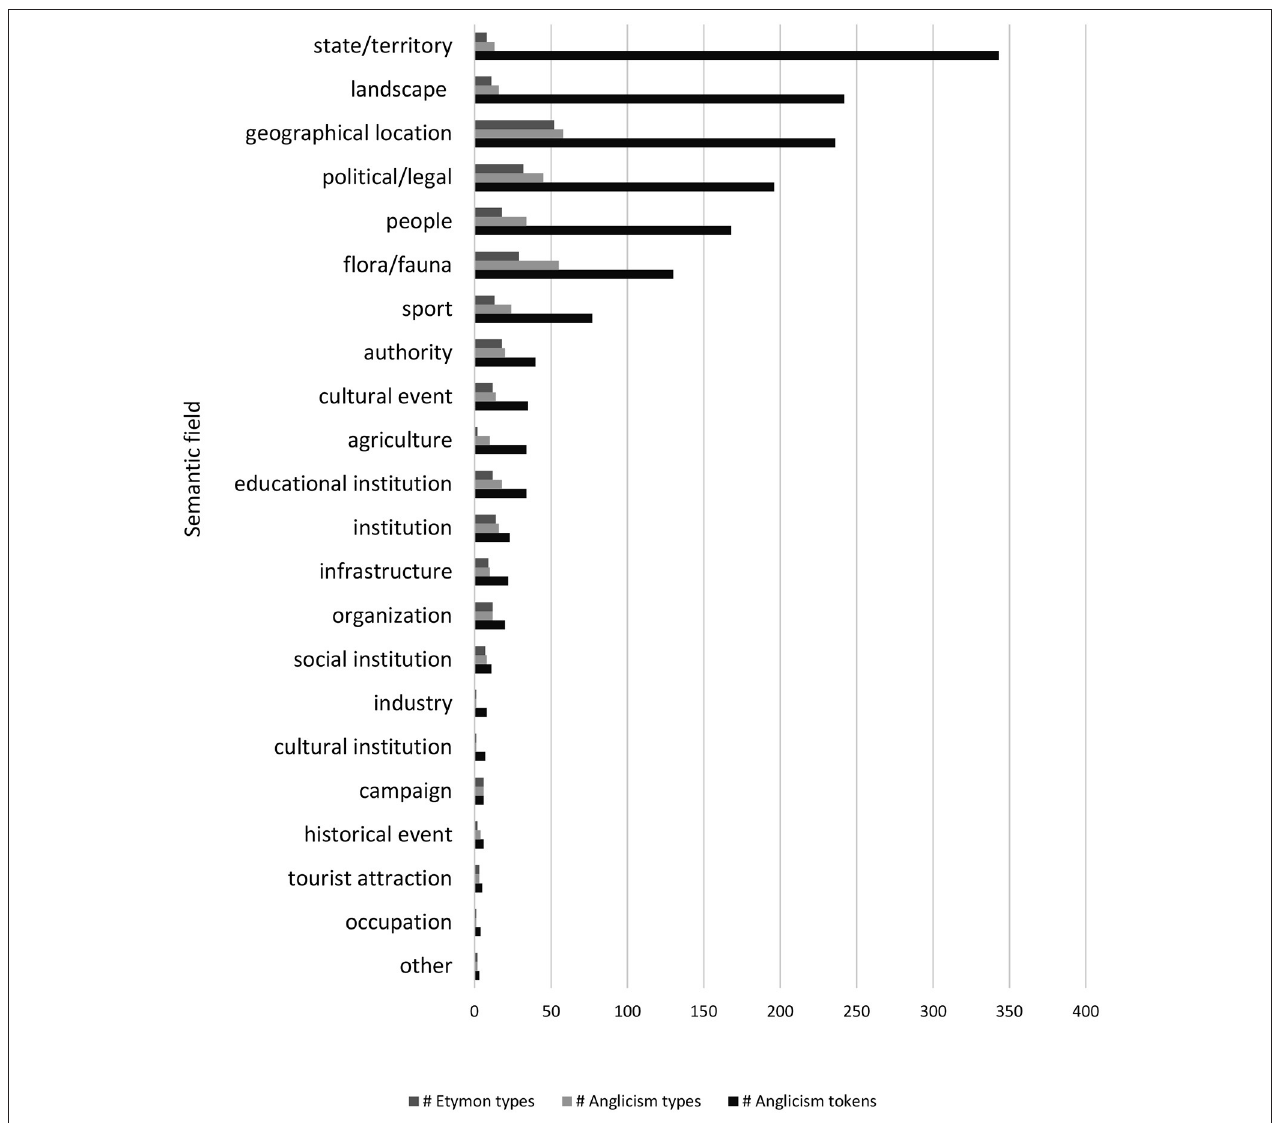
FIGURE 1 | Semantic fields by anglicism tokens and